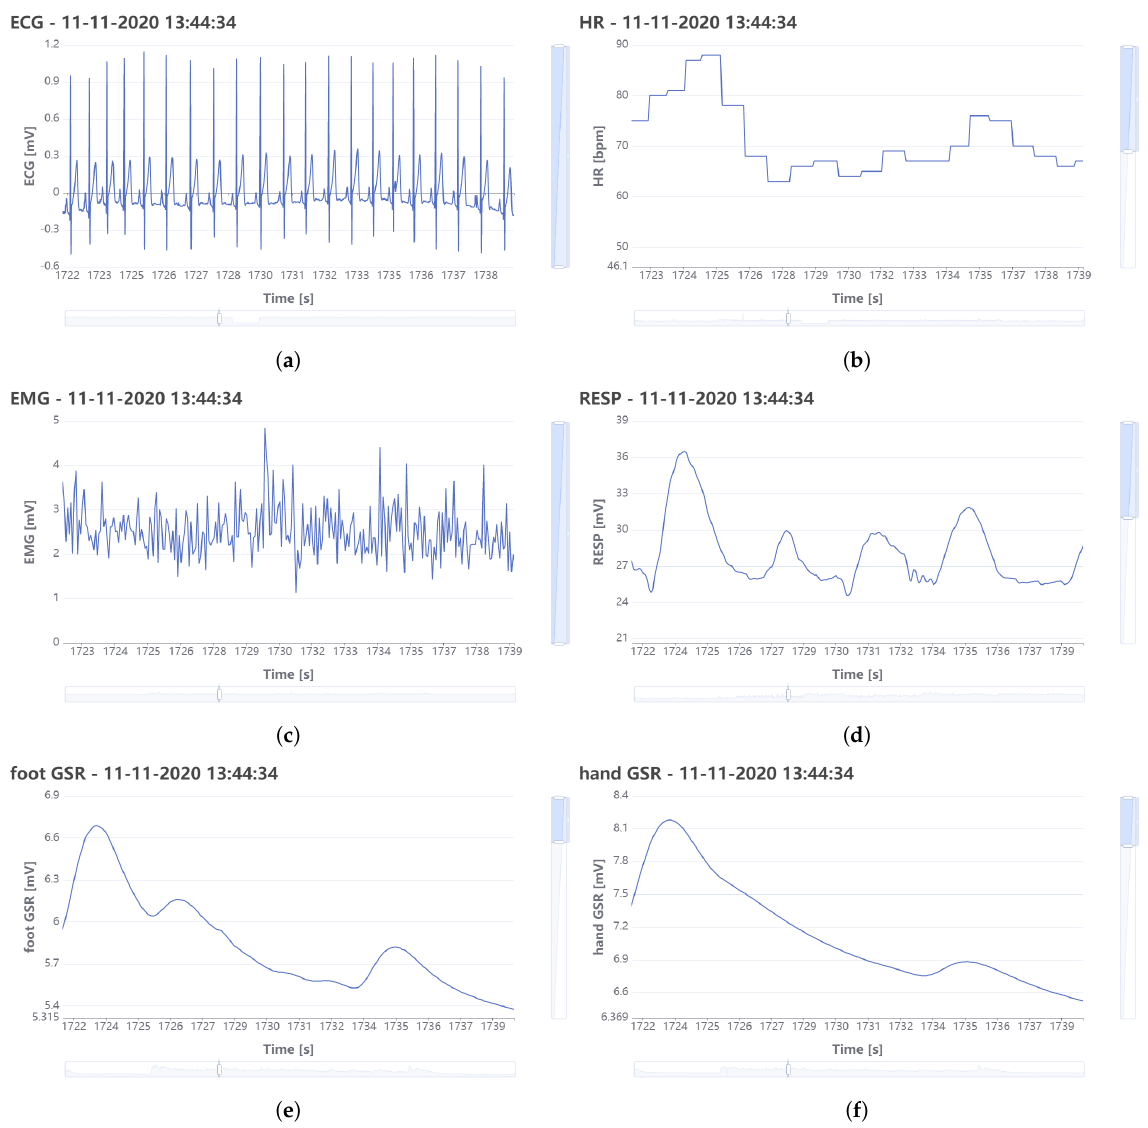
Figure 11. Physiological signals recorded with wearable sensors: ( a ) ECG; ( b ) HR; ( c ) EMG; ( d ) Respiration; ( e ) foot GSR; ( f ) hand